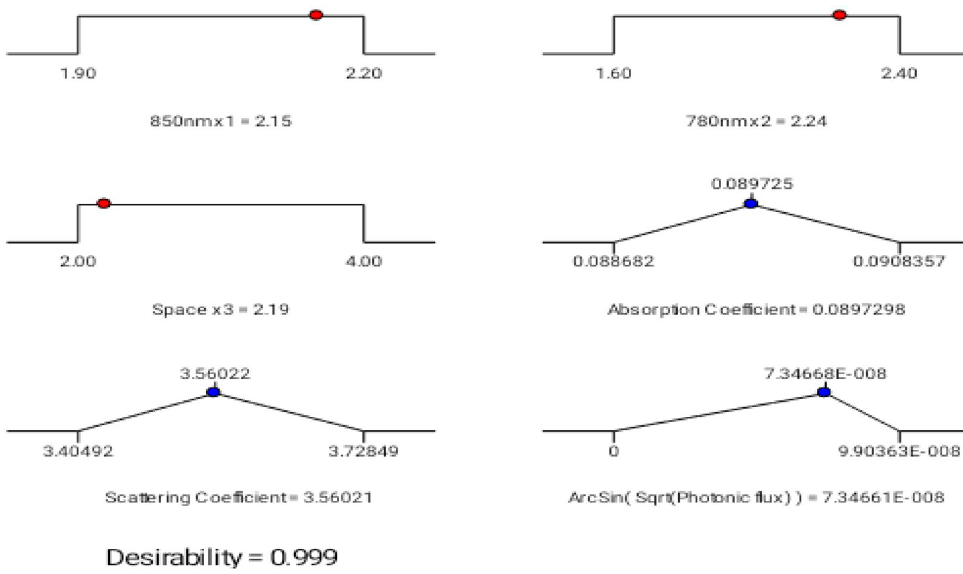
Figure 8. Ramp functional graph for optimum results—displays simple interpretation of input values to produce an optimized desirable response of